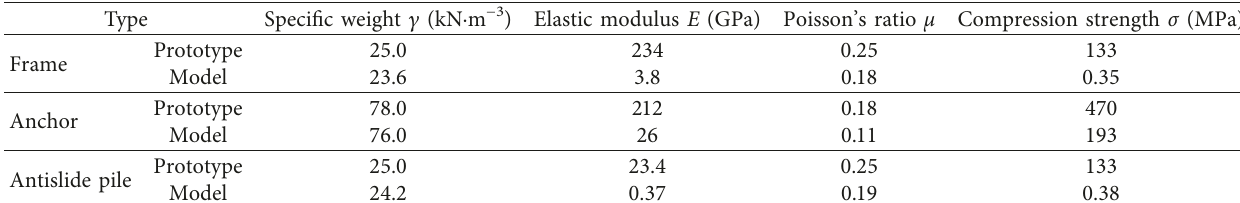
Table 2: Reinforced structure mechanical parameters of prototype and model